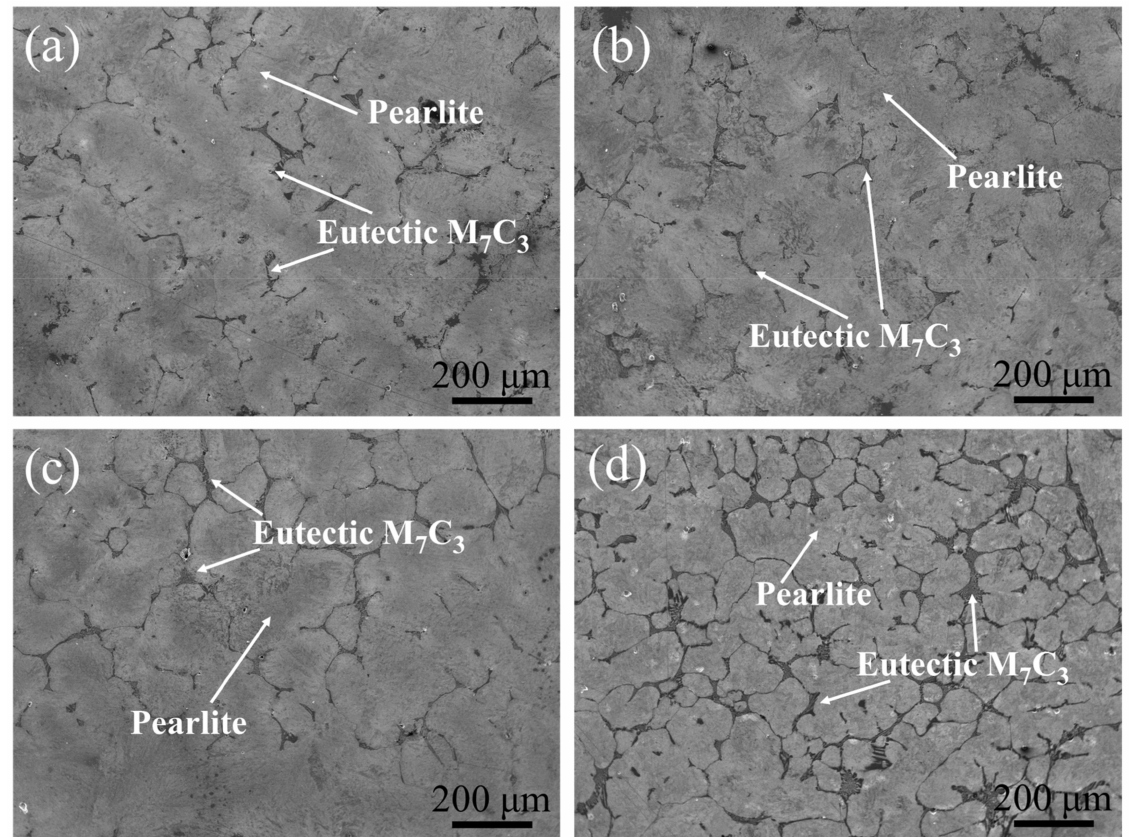
Figure 3. SEM images of the as-cast microstructures of the CILs. ( a ) CIL-1; ( b ) CIL-2; ( c ) CIL-3; ( d )